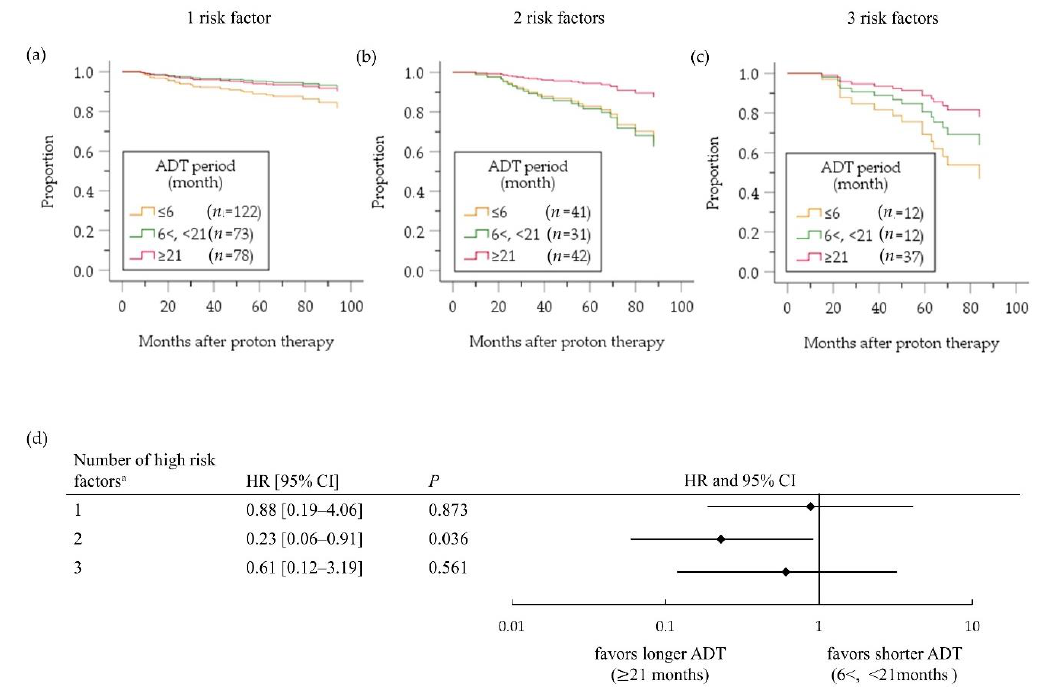
Figure 6. Cumulative survival function ( a – c ) and forest plots ( d ) assessing the risk of biochemical relapse in high-risk patients according to the number of high-risk factors a . ADT, androgen deprivation therapy; HR, hazard ratio; CI, confidence interval. a The three high-risk factors are T stage 3a–4, PSA level >20 ng/mL, and Gleason score ≥8.